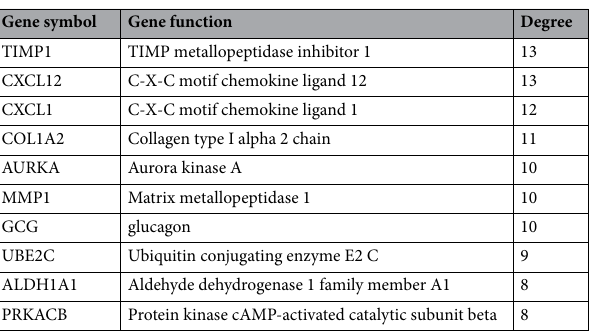
Table 5. The Top 10 in network string_interactions.tsv ranked by Degree